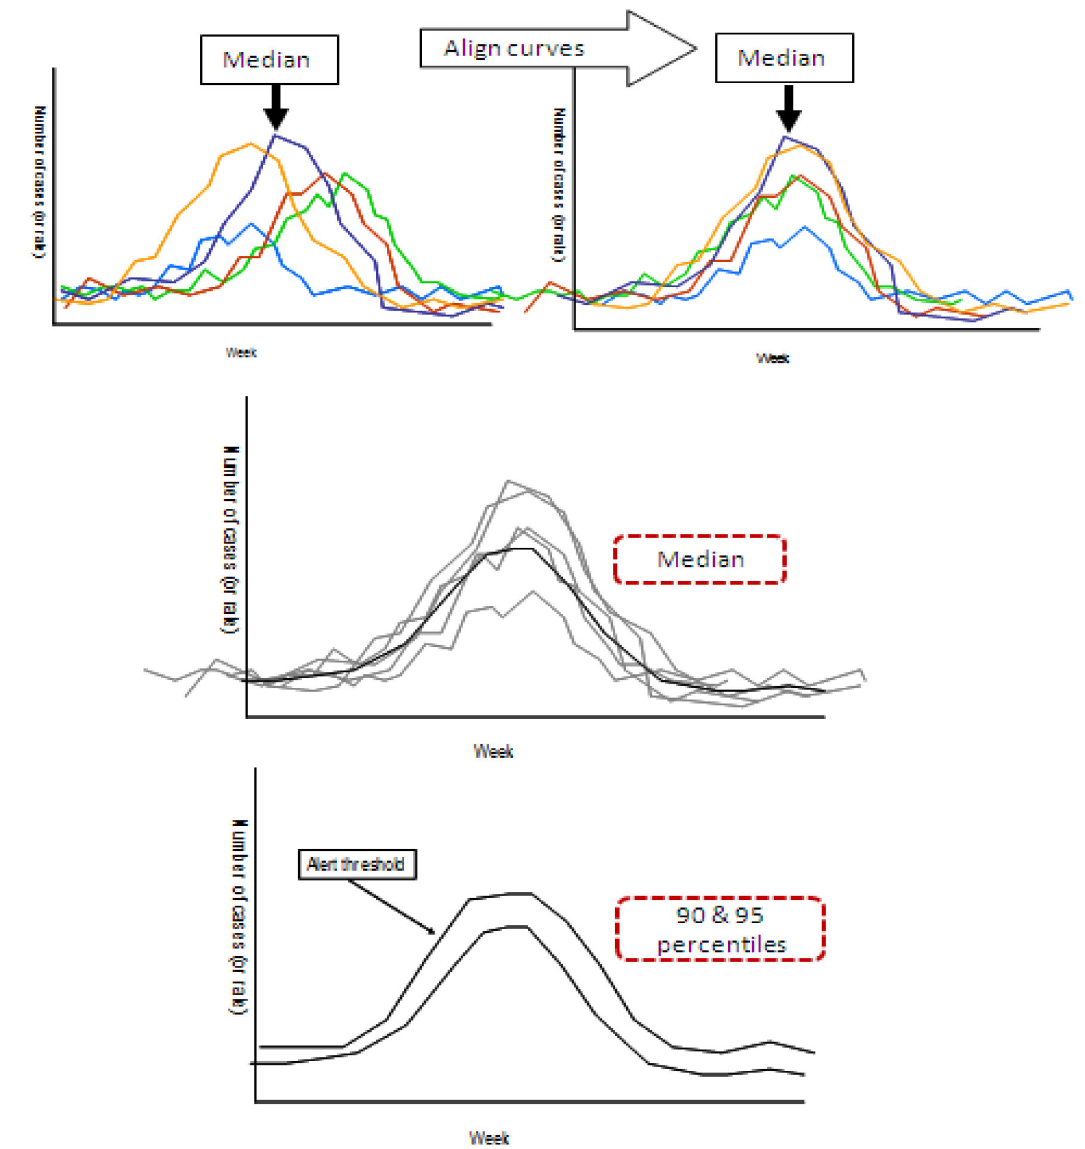
Figure 1. WHO method for determining thresholds. Figure adapted from the WHO Global Surveillance Standards for Influenza